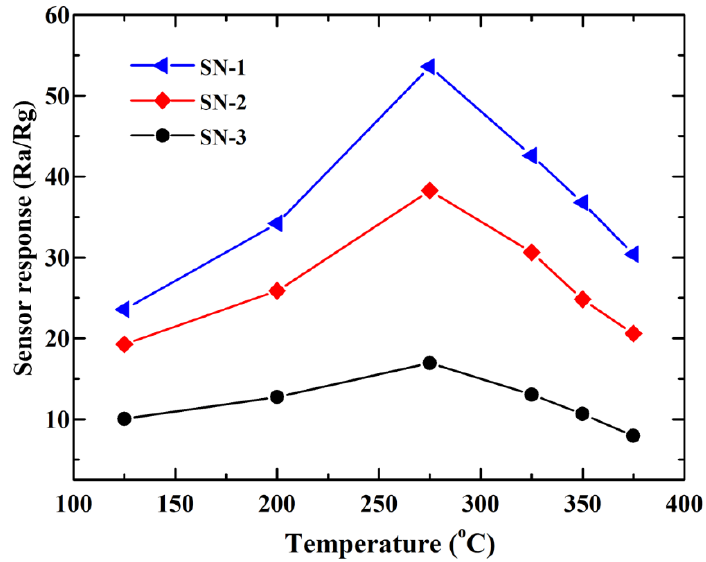
Figure 4. Sensor responses of as-prepared SnO 2 -based gas sensors towards 50 ppm HCHO vapor.